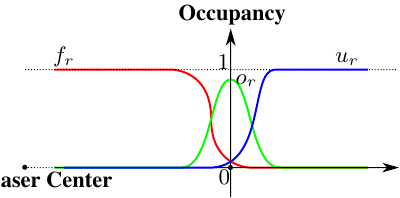
Figure 2. Occupancy in ray direction considering uncertainties Now, the occupancy has been defined only in the ray direction.